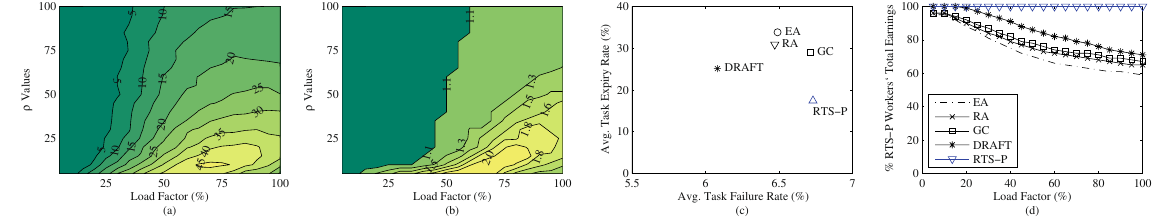
Figure 3. Experimental results under the worker behaviour characteristic setting = + μ R h : ( a ) The percentage of all tasks successfully sub-delegated by RTS-P agents; ( b ) The average sub-delegation chain length; ( c ) The average task expiry rates vs. the average task failure rates; ( d ) The total income as a percentage of the total income of RTS-P agents.